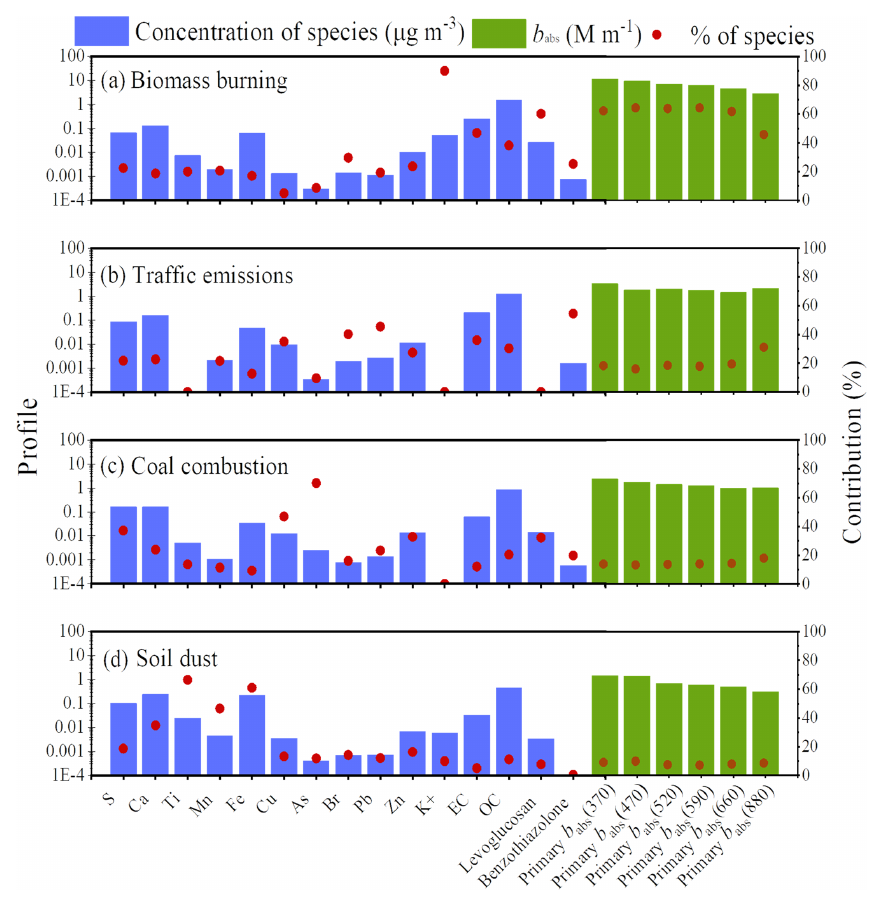
Figure 2. Four aerosol light absorption sources identified by a positive matrix factorization (PMF) model. Concentrations (µgm − 3 ) of the chemical species for each source are in purple. Primary b abs ( λ) at six wavelengths ( λ = 370, 470, 520, 590, 660 or 880nm) in each source (Mm − 1 ) is in